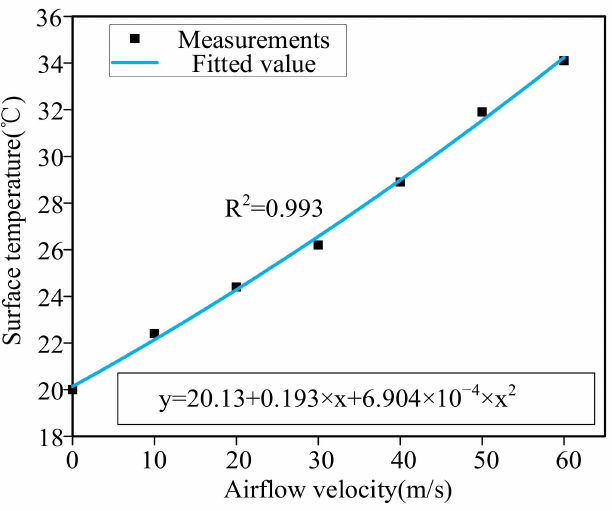
insulating medium surface temperature is 293 K. When the airflow velocity reaches 50 m/s, the insulating medium surface temperature rises to 304.9 K, which is 11.9 K higher than that without airflow. The air velocity has a great influence on the insulating medium surface temperature, which in turn affects the movement of the insulating medium carriers. The characteristic curve of the insulating medium surface temperature variation with airflow velocity is obtained by fitting, as shown in Figure 24.